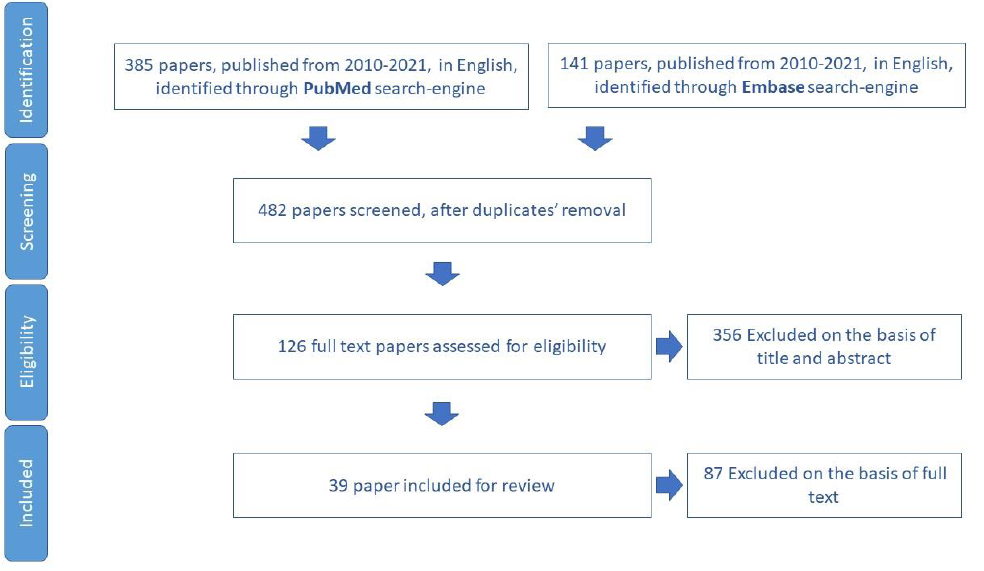
Figure 6. Process of study selection for fall risk assessment.